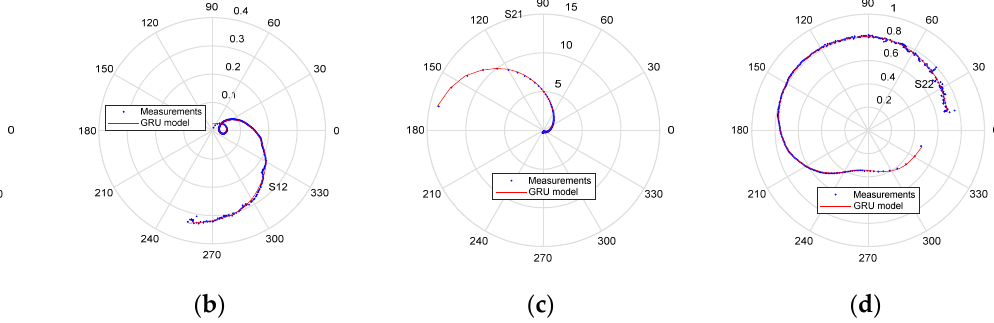
Figure 17. Measured (blue symbols) and GRU simulated (red lines) behavior of ( a ) S 11 , ( b ) S 12 , ( c ) S 21 , and ( d ) S 22 with the frequency range spanning from 200 MHz to 65 GHz for the DUT at V DS = 30 V, V GS = − 3.1 V, and T a = 200 °C.